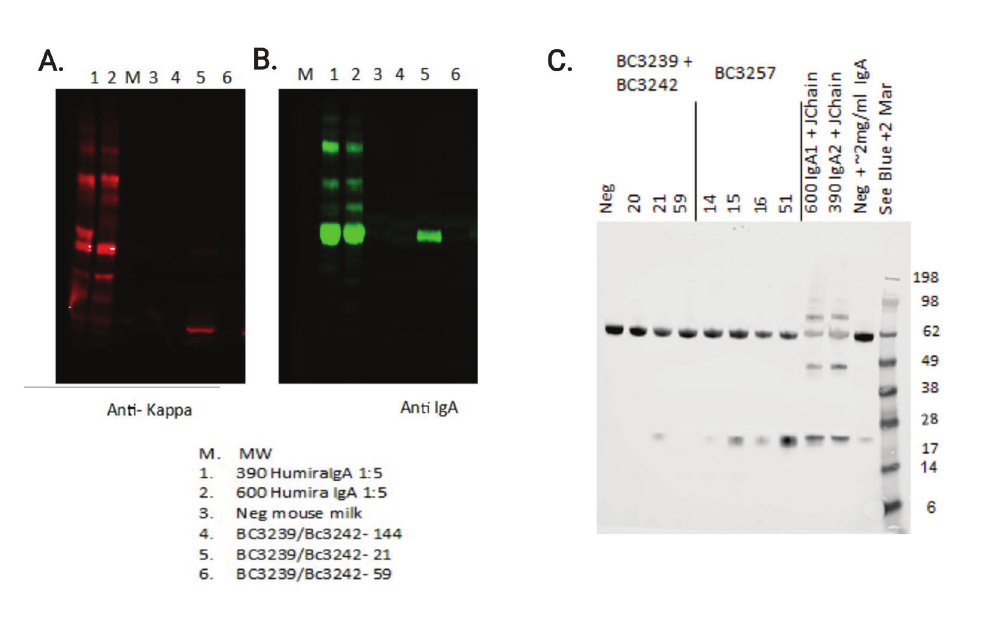
Supplementary Figure 6. Western blots confirm the presence of HC, LC, and J chain . Milk samples from control mice secreting HUMIRA IgA, previously unpublished, or ZAC-3 hIgA1 founder females, numbers 144, 21, 59 containing the BC3239 and BC3242 constructs were analyzed via western blot for (A) Kappa light chain and (B) human IgA. Lanes 1, 2, containing positive control Human IgA and lane 5, containing milk from founder female 21, exhibit highly positive signal for both Kappa LC and IgA. (C) Western blot showing that milk from mouse 21 is also positive for J-chain in comparison to positive con- trols. Data in (C) also includes preliminary findings from ZAC-3 IgA2 constructs, mouse numbers 14, 15, 16, 51, which were not pursued. ZAC-3 hIgA founder female 21 was subsequently